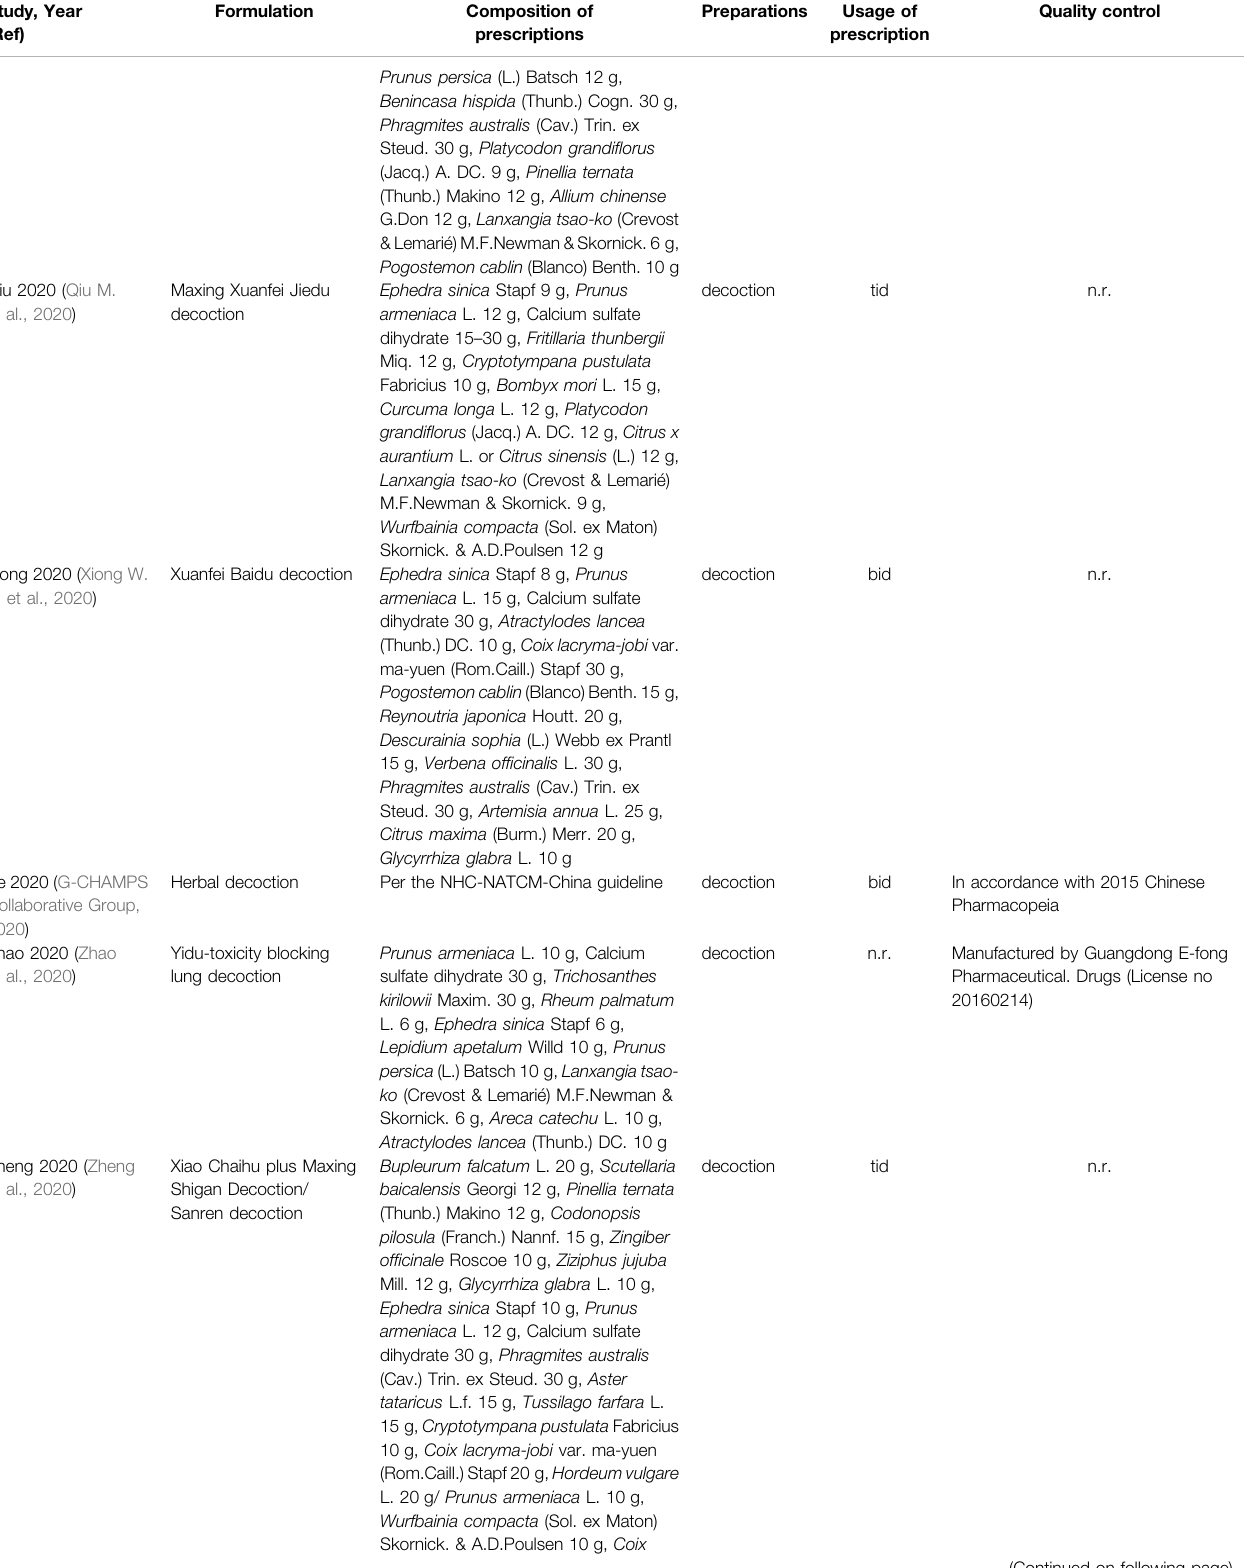
TABLE 2 | ( Continued ) Compositions and usage of herbal medicine for the treatment of